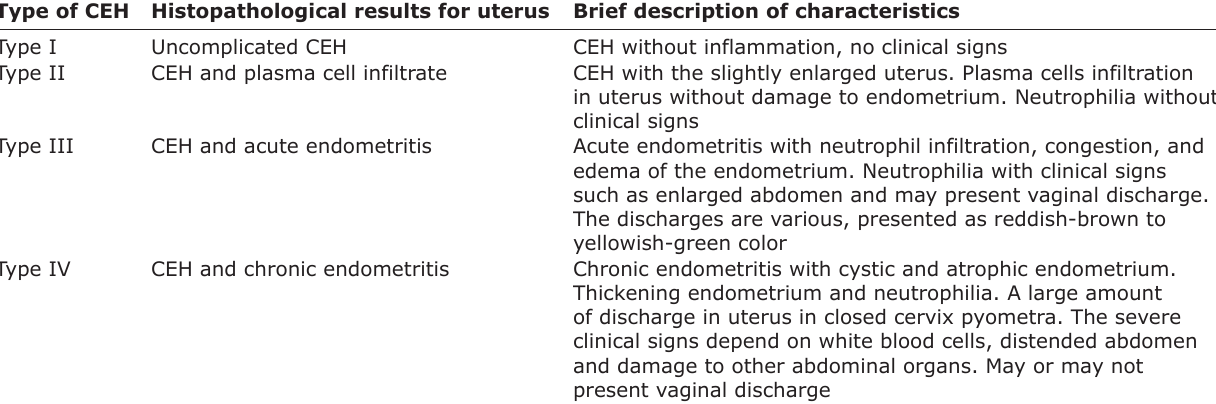
Table-3: Histopathological types and lesions of CEH from canine uterine tissues. Type of CEH Histopathological results for uterus Brief description of characteristics